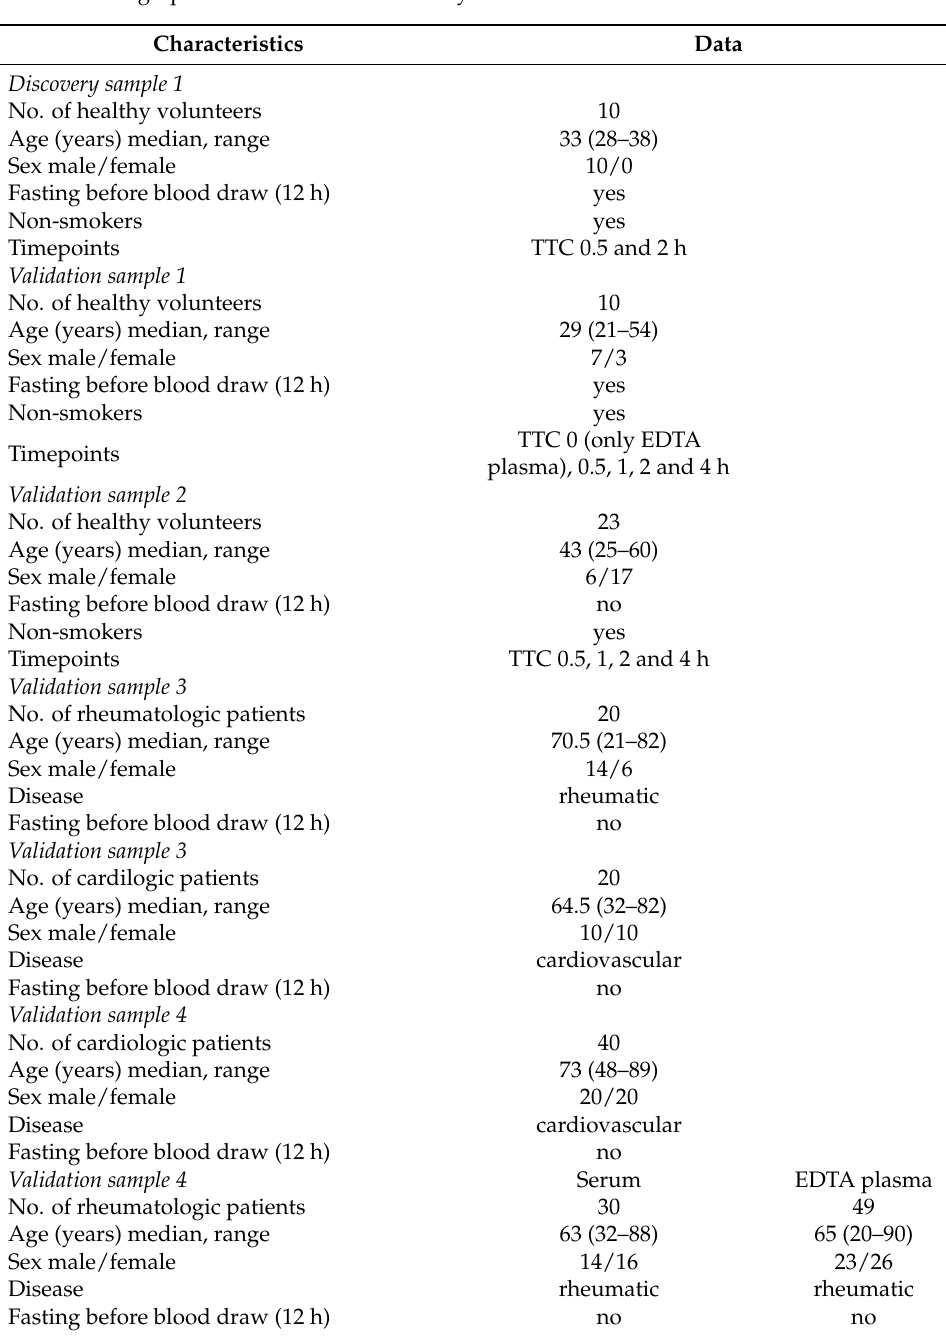
Table 4. Demographic and clinical data of study